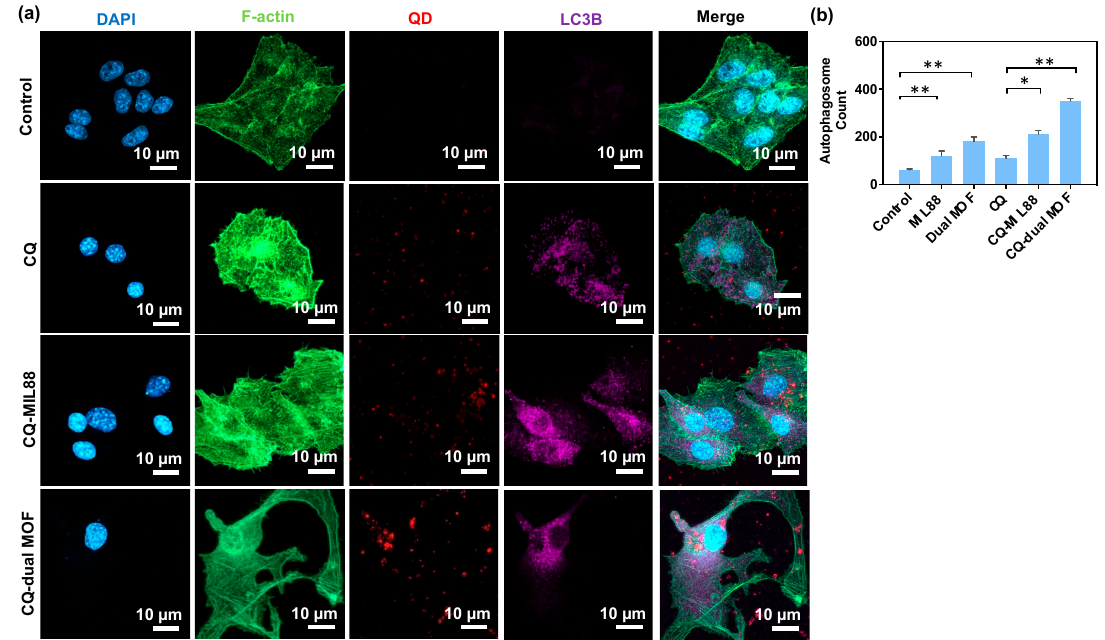
Figure 5. Autophagy regulation by CQ, CQ-MIL88, and CQ-dual MOF. ( a ) Confocal florescence images of B16F10 cells incubated with CQ, CQ-MIL88, and CQ-dual MOF (100 µg/mL). Purple florescence represents LC3B expression, which shows the quantity of autophagosomes. Blue, green, and red fluorescence represent nucleus, cytoskeleton, and NP staining with DAPI, F-actin, and QD, respectively. The experiment was conducted for three times on three independent 6-well plates. ( b ) The quantification of autophagosome of B16F10 cells incubated with CQ, CQ-MIL88, and CQ-dual MOF (100 µg/mL) by image J analysis software. Quantitative significant statistical data were calculated via Student’s t -test, * p < 0.05, ** p <